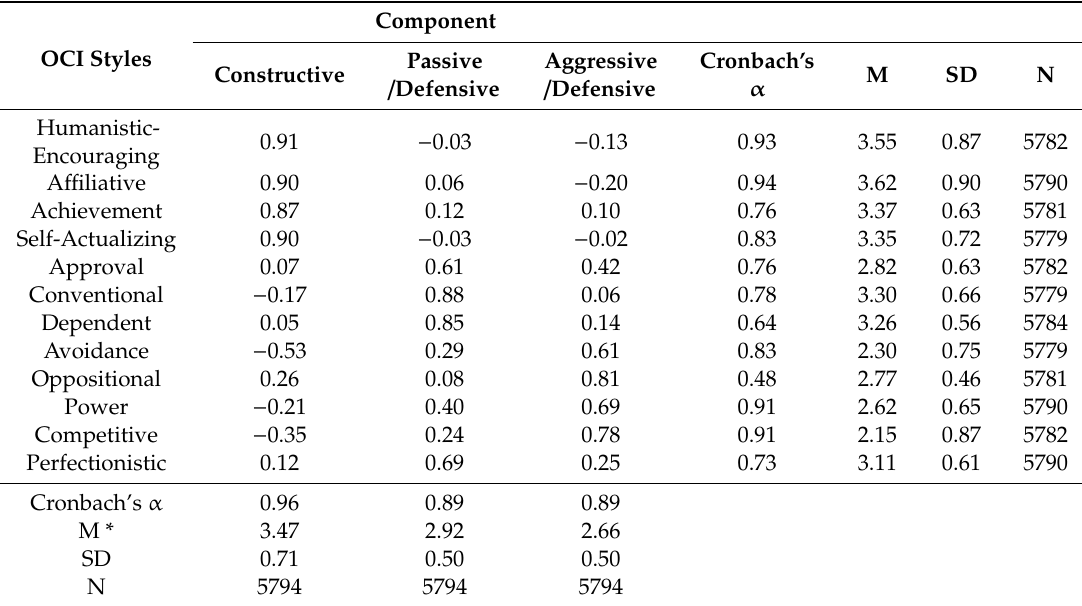
Table 4. Reliability, principal factor component analysis and descriptive statistics of the OCI styles.